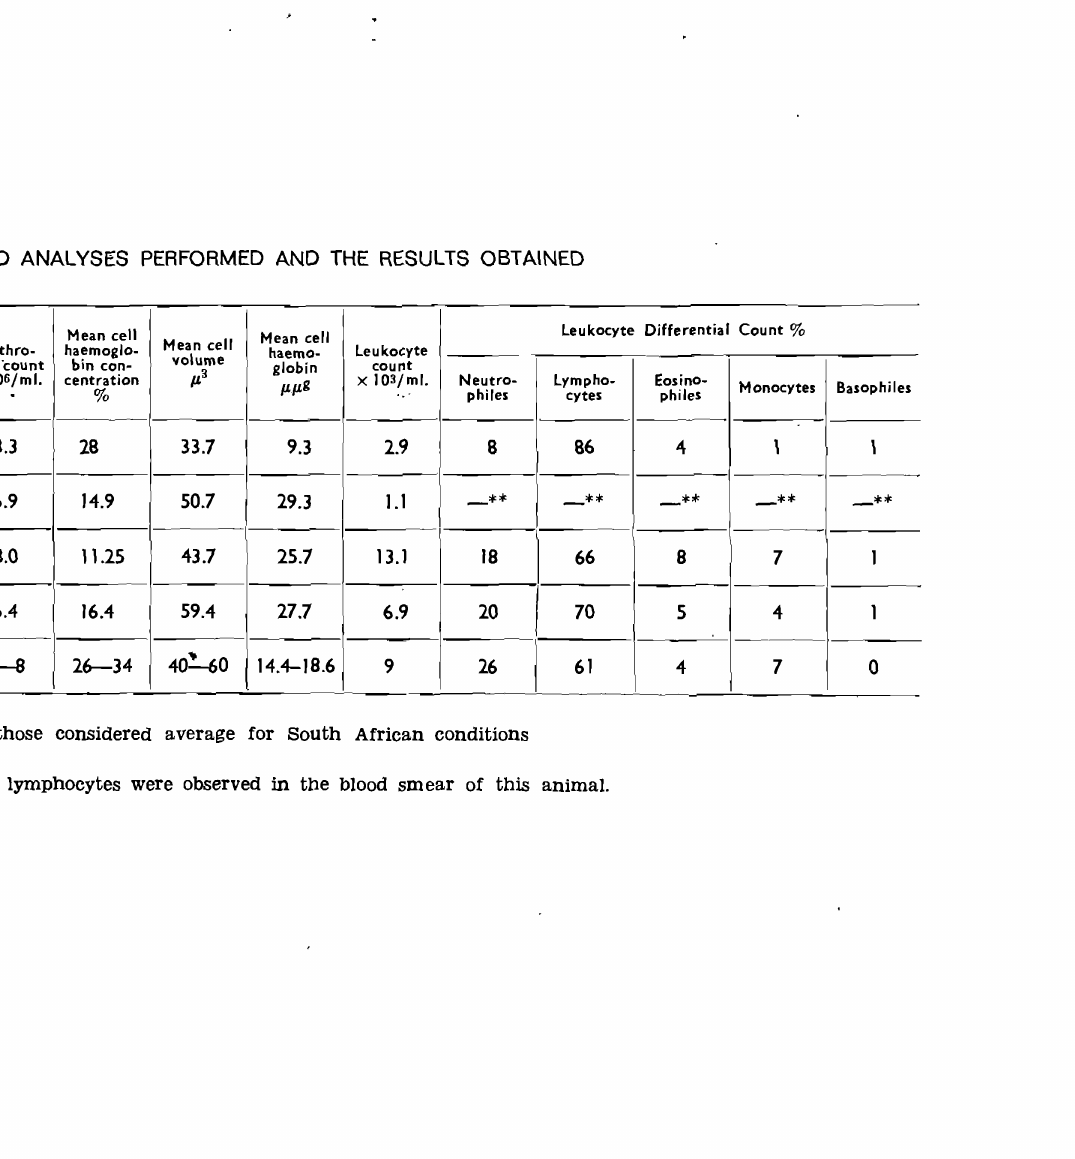
Table: BLOOD ANALYSES PERFORMED AND THE RESULTS OBTAINED